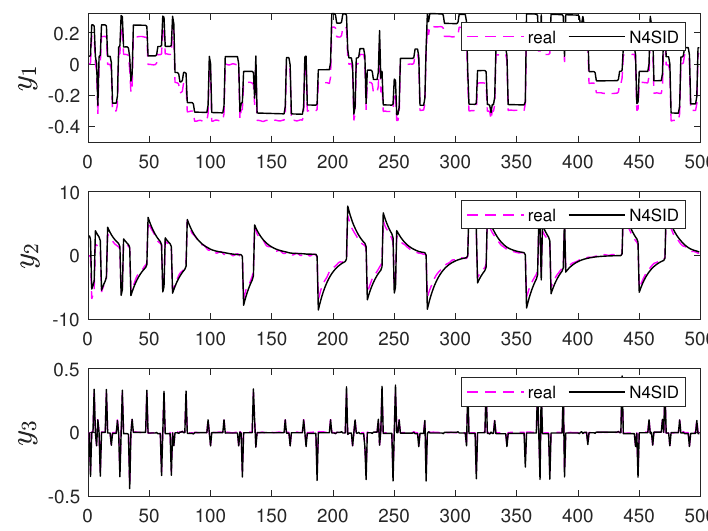
Figure 5. Singular value histogram.